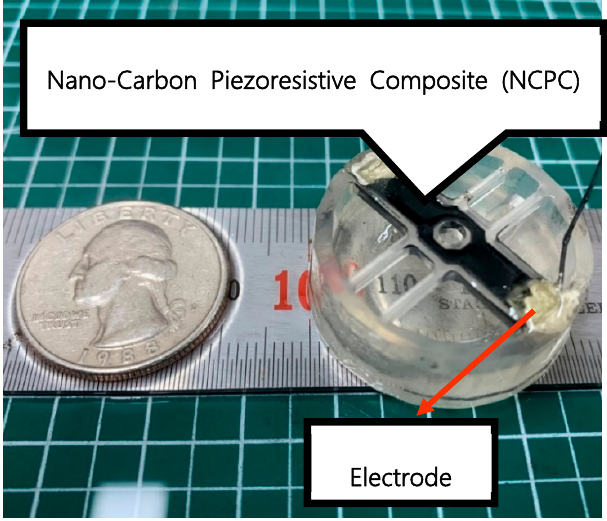
Figure 3. The 3D PLC using nanocarbon composite strain (diameter: 30 mm, height: 10 mm, resistance: 920 k Ω ).